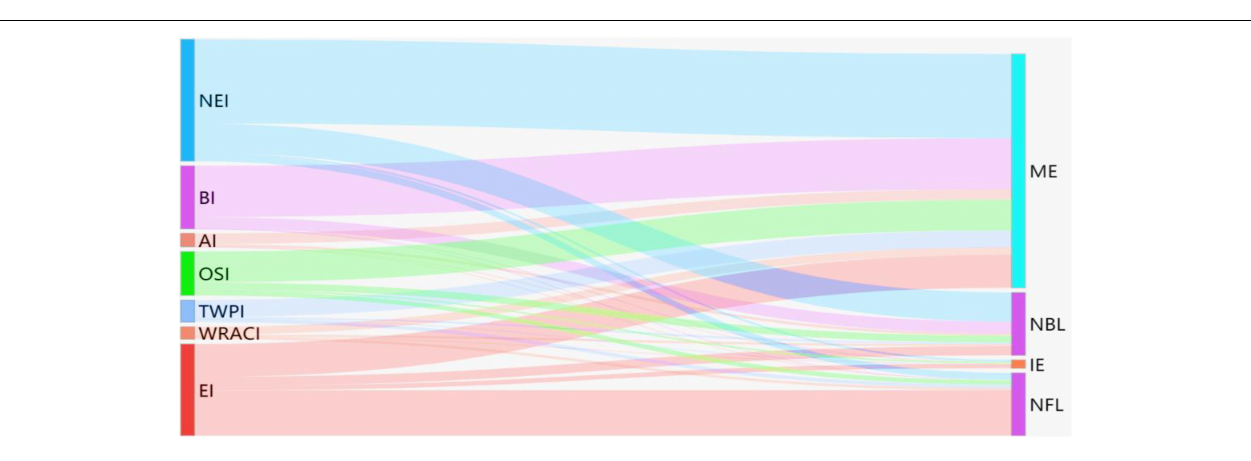
FIGURE 5 | Break decomposition of the energy industry in Shaanxi Province in